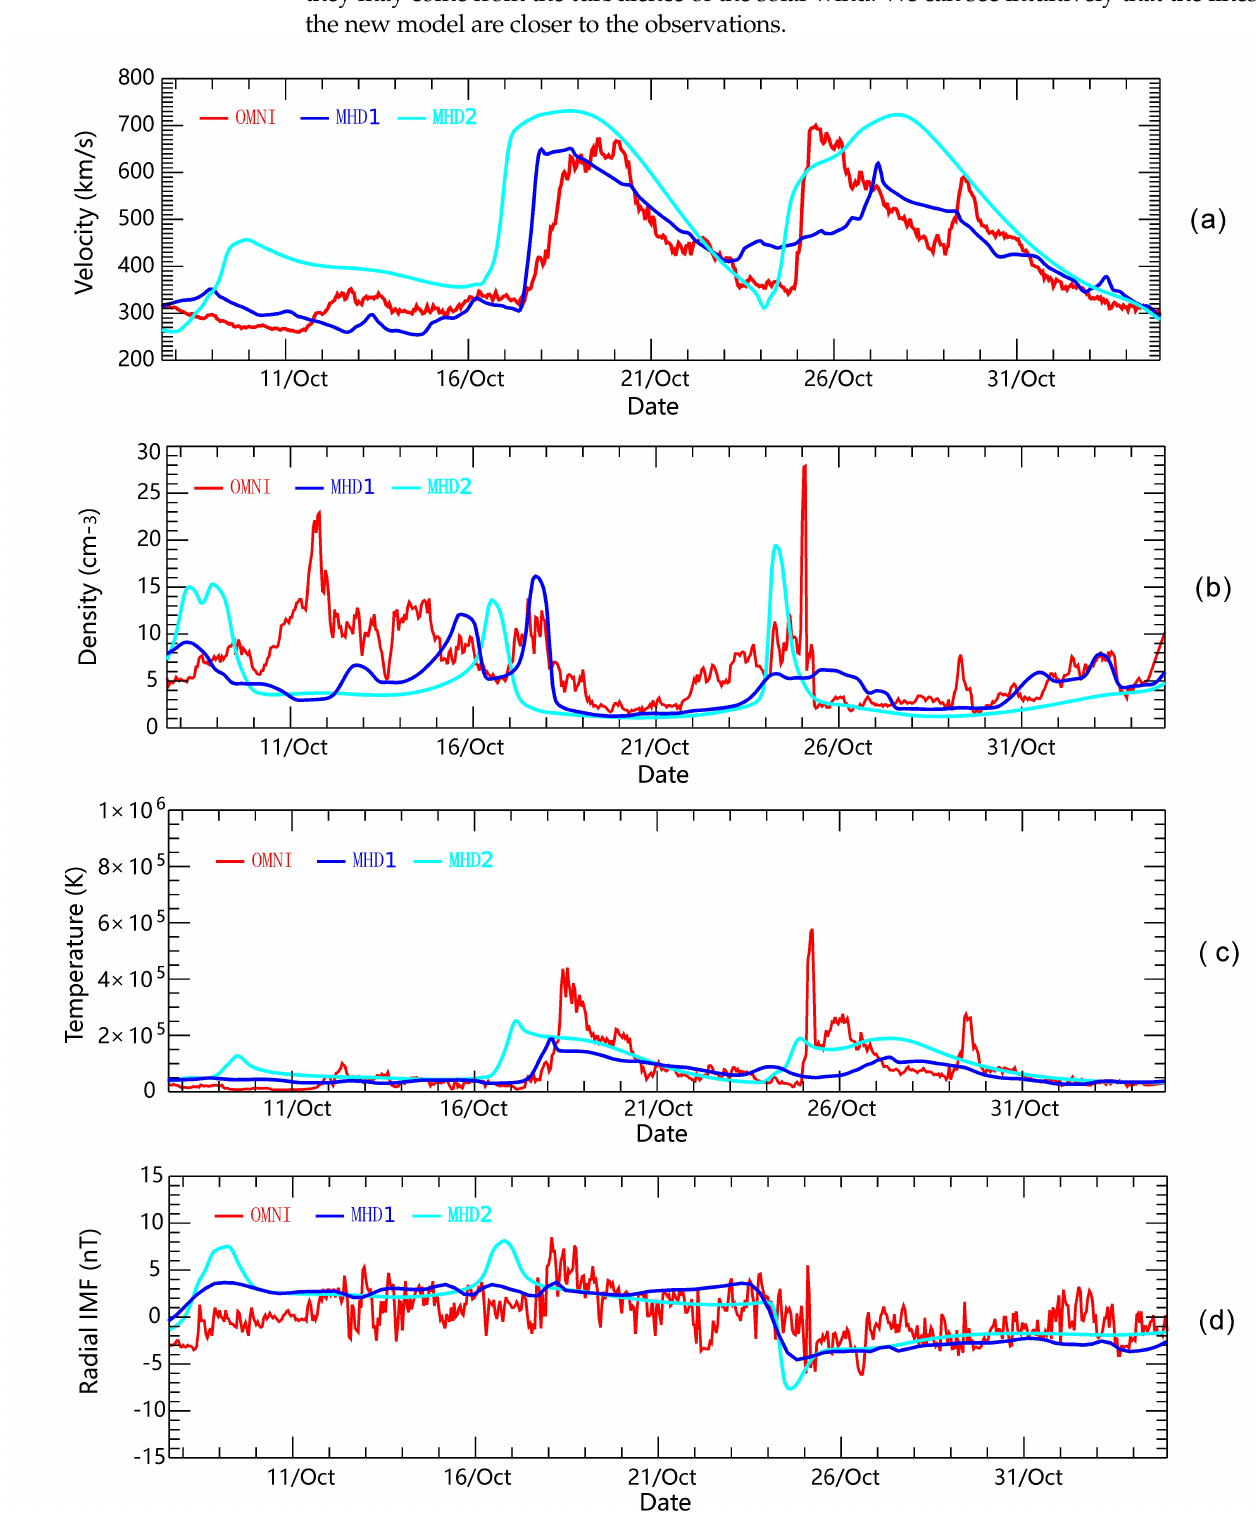
Figure 6. Comparison of the MHD modeled solar wind ( a ) velocity, ( b ) density, ( c ) temperature and ( d ) radial IMF at 1AU during CR2062 with the OMNI observation, where MHD1 is the new model driven by multiple observations and ANN, and MHD2 is our previous MHD